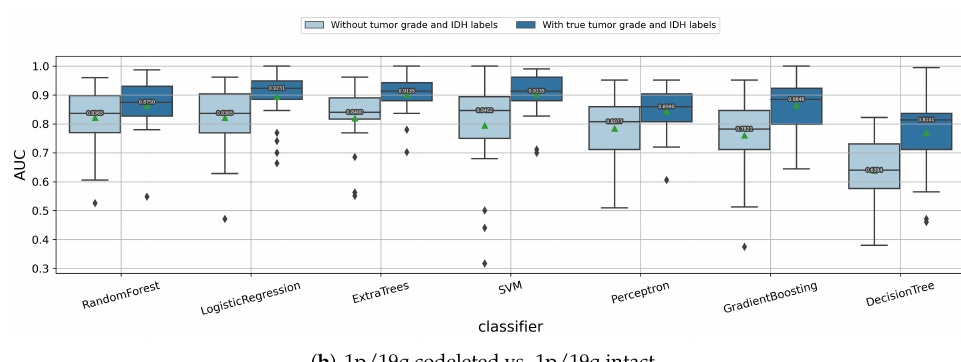
Figure 9. Comparison of whether it helps to improve the performances by using the classifier chain idea, with the true labels of previous classifiers given. ( a ) Predicting IDH mutation status of the gliomas; ( b ) predicting 1p/19q codeletion status of the gliomas.